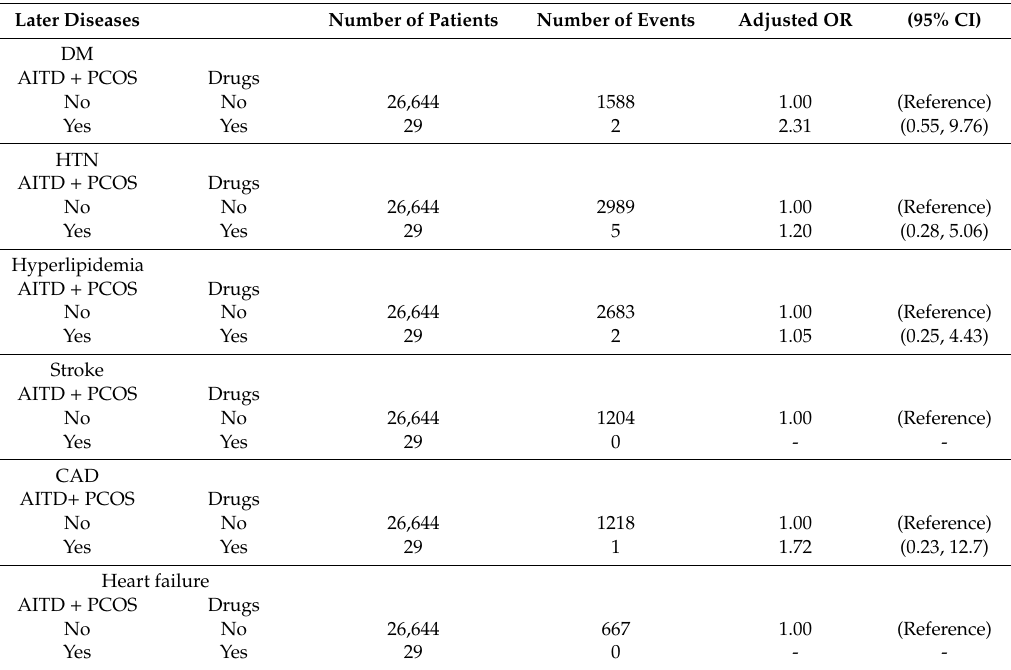
Table 4. The distribution of later diseases in the AITD and PCOS patients with and without drug usage. Later